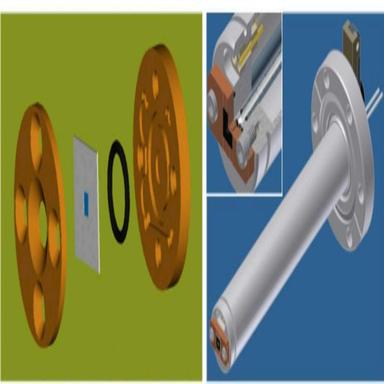
Static liquid cell (left) and flow liquid cell (right).